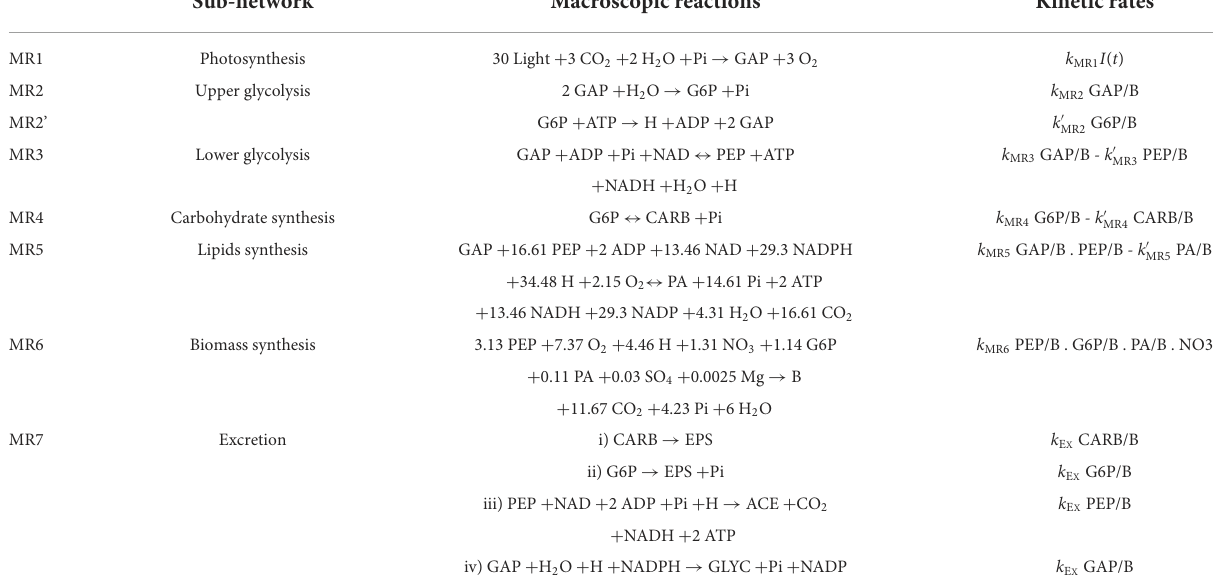
TABLE 1 Sub-networks and resulting macroscopic reactions and kinetic rates. Sub-network Macroscopic reactions Kinetic